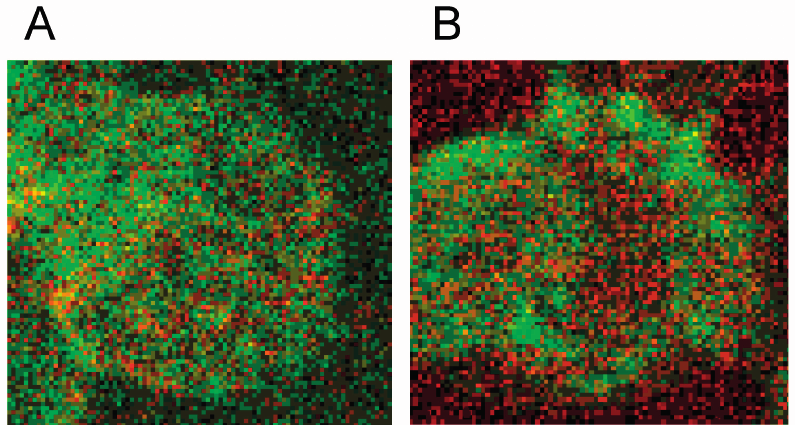
Figure 17. Merger of red (band 3) and green (spectrin) channels of the confocal microscope after examination of double stained erythrocytes suspended in RCM/plasma mixtures (reprinted from reference [21]). ( A ) Erythrocyte suspended in Iodixanol/plasma mixture (30% v / v ); ( B ) Erythrocyte suspended in Iopromide/plasma mixture (30% v / v ). (Primary magnification: 1:63; zoom factor